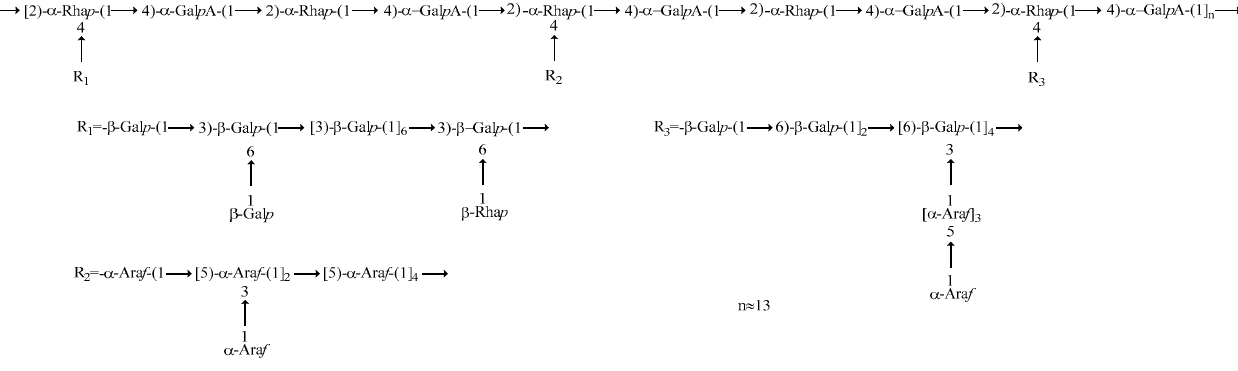
Figure 2. The proposed structure of LBP1C-2.